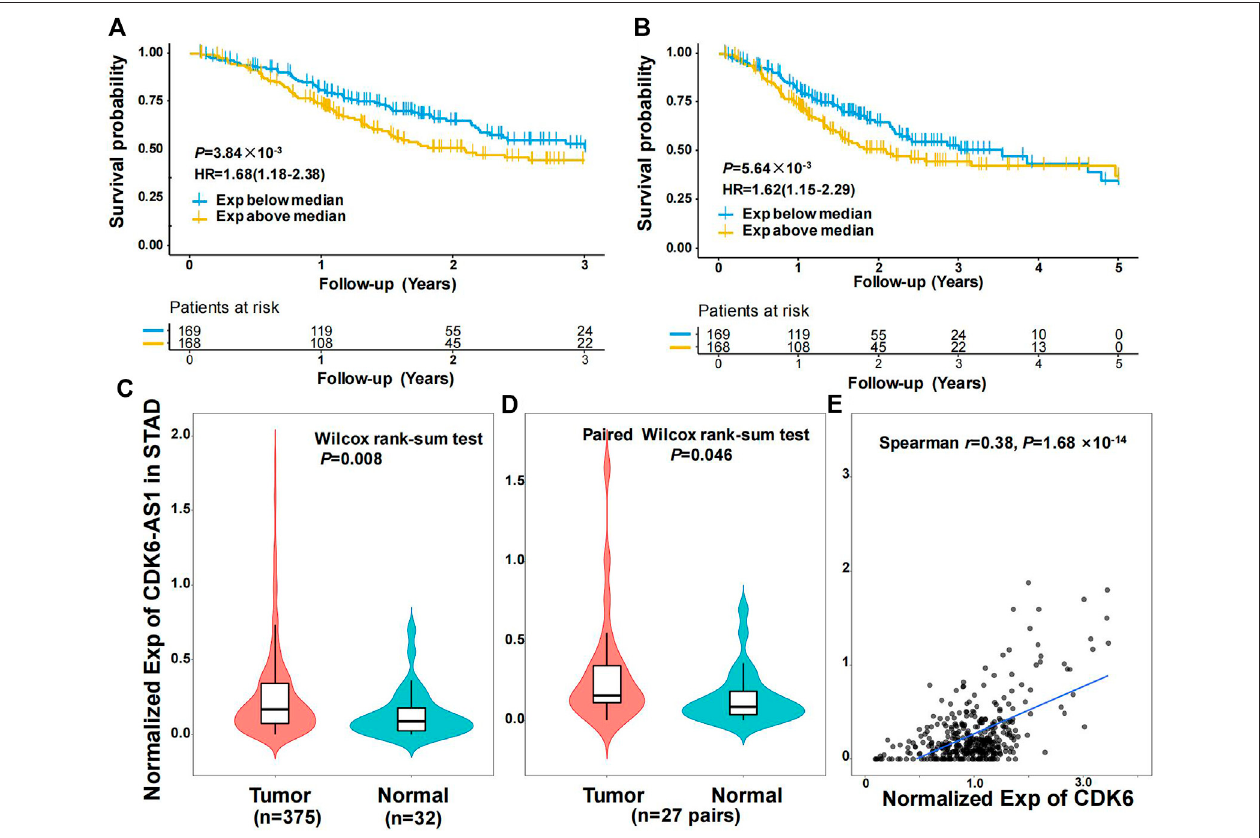
FIGURE1| CharacteristicsofeRNA CDK6-AS1 ingastriccancer. (A) Kaplan – Meier3-yearoverallsurvivalcurveforgastriccancerpatientswith CDK6-AS1 lowand high expression. (B) Kaplan – Meier 5-year overallsurvivalcurveforgastric cancerpatientswith CDK6-AS1 lowand high expression. (C) Differentialexpression of CDK6- AS1 between unpaired tumor and adjacent normal tissues. (D) Differential expression of CDK6-AS1 between paired tumor and adjacent normal tissues. (E) The correlation between the CDK6-AS1 and its target gene, CDK6 expression